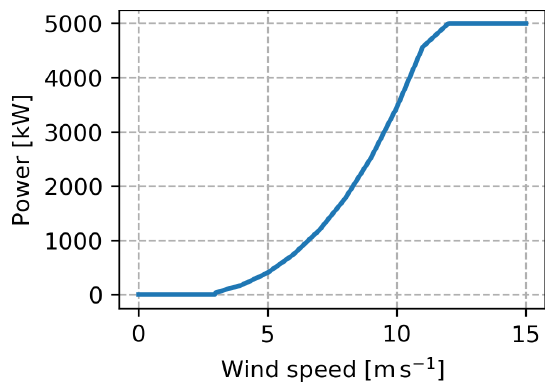
Figure 11. Power curve for the NREL 5MW reference wind turbine (Jonkman et al.,